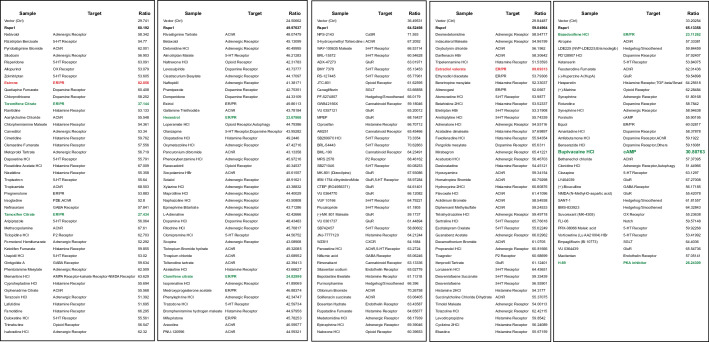
ESR1-luciferase activities induced by RSPO1 in combination with a GPCR inhibitor library HEK293 cells with transiently expressing ESR1-luciferase reporter were cultured in the presence of RSPO1, and screened for the molecules that could suppress the luciferase activities using a GPCR inhibitor library (Selleck, L2200).Luciferase activities were measured.